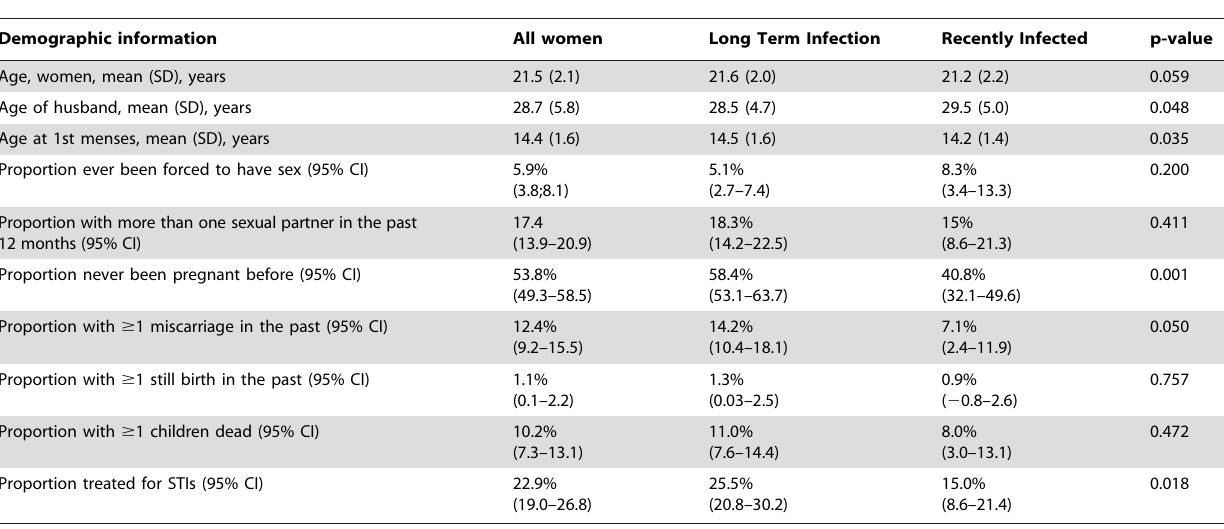
Table 1. Patient demographic data grouped according to their infection duration based on the BED results.